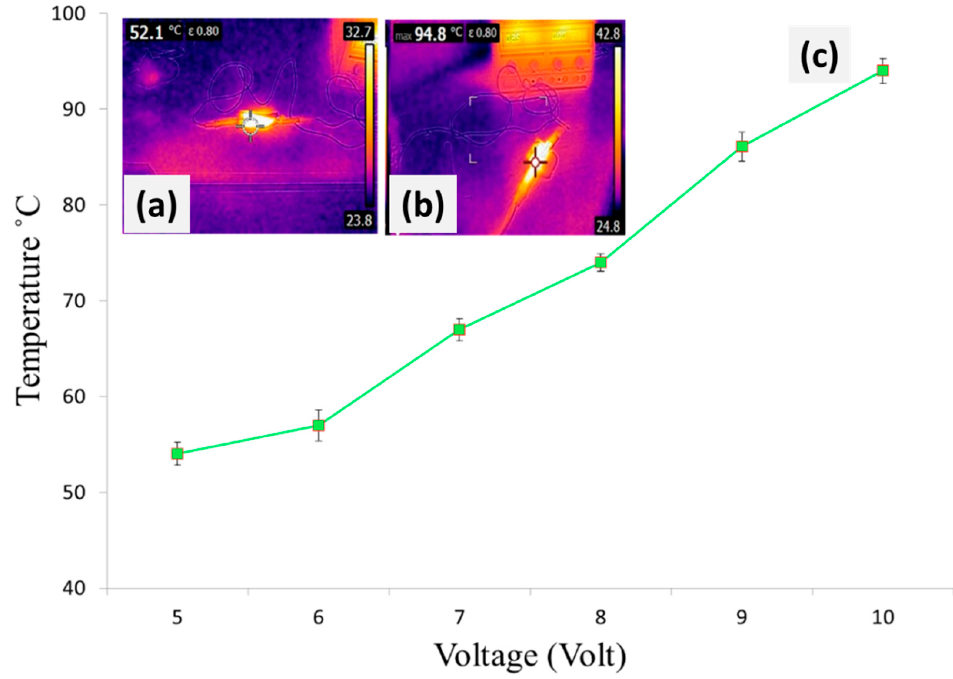
Figure 16. Surface temperature of ( a ) Silver plated fabric at 5 volts and 1 min, ( b ) Silver plated fabric at 5 volt and 10 min, and ( c ) Silver plated fabric at 5–10 volt .